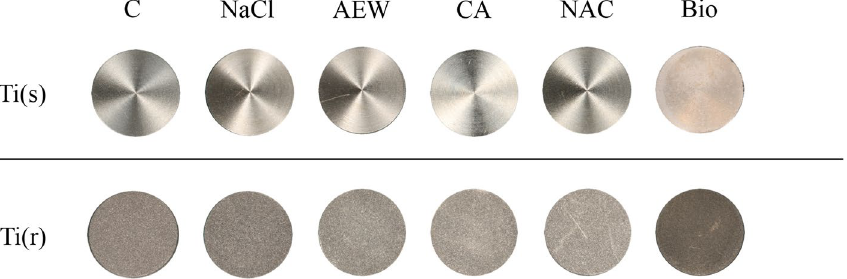
Figure 3. Photographic images of the two different titanium surfaces following application of four different decontamination methods (NaCl: gauze-soaked in saline, AEW: gauze-soaked in 0.1% alkaline electrized water, CA: gauze-soaked in citric acid, NAC: gauze-soaked in 10% N -acetyl-l-cysteine), control (C) and biofilm- contaminated discs